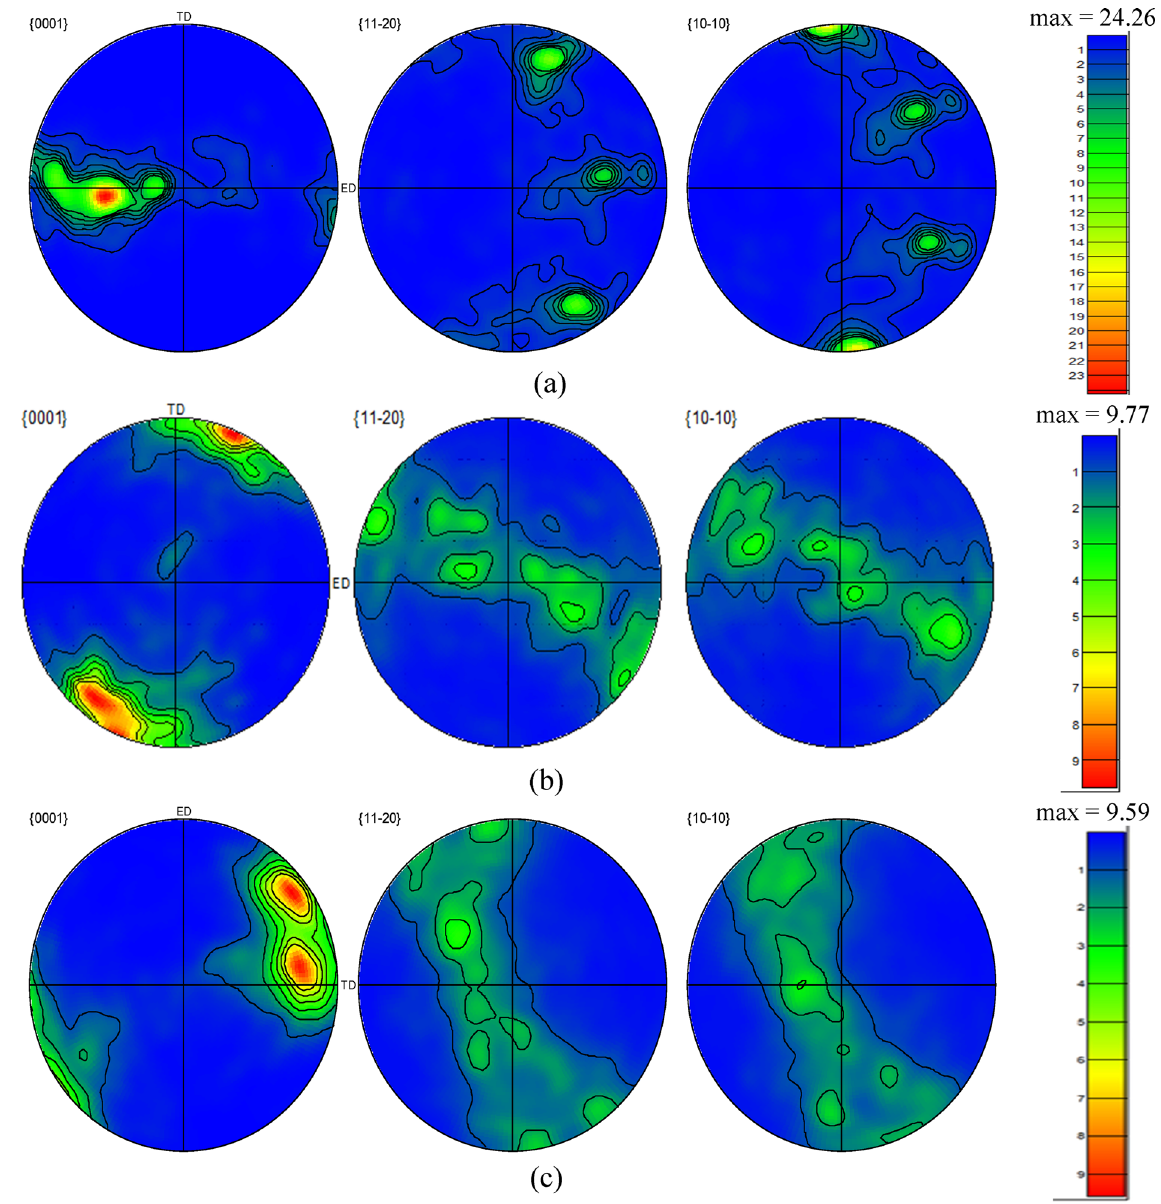
Figure 8: { 0001 } , { 11 – 20 } and { 10 – 10 } pole fi gures of ( a ) AA - Mg BM and ECAP samples processed using the 90° - die angle processed through ( b ) 1 - pass, ( c ) 2 - A, ( d ) 2 - Bc, and ( e ) 2 -